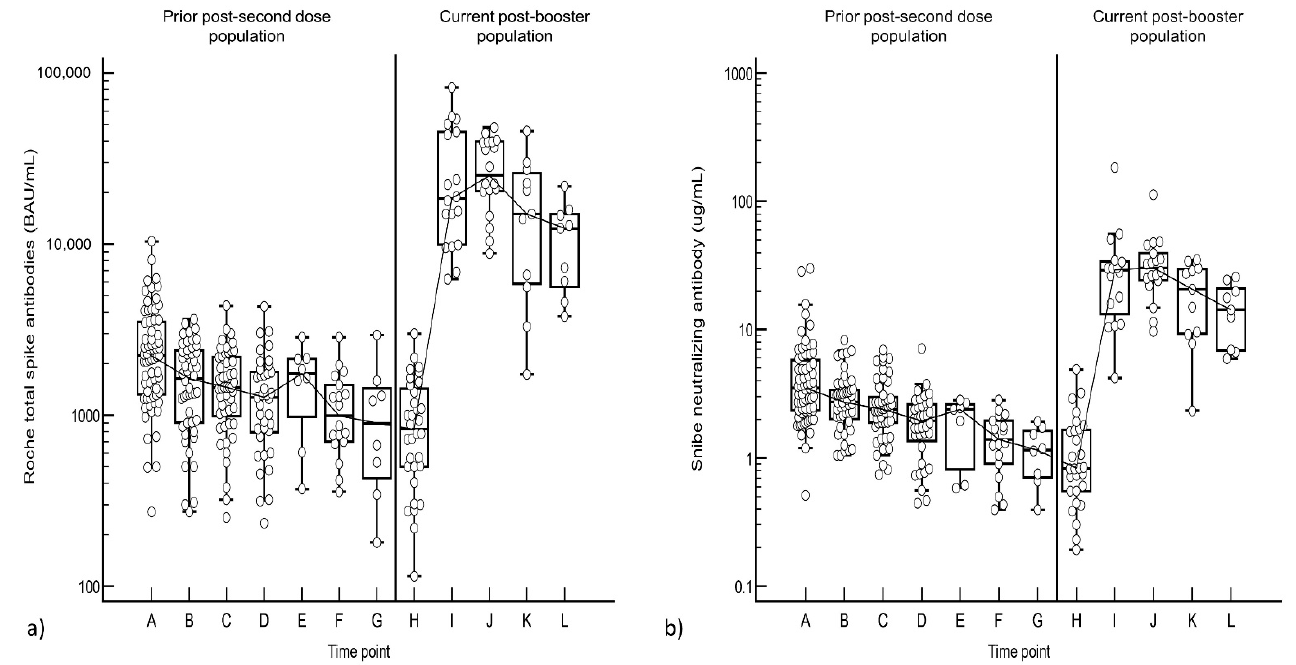
Figure 3. ( a ) Total spike and ( b ) Neutralizing Antibody trend between the second and tion doses. The time points are: A: D2D20, B: D2D40, C: D2D60, D: D2D90, E: D2D120, F: D2D150, third vaccination doses. The time points are: A: D2D20, B: D2D40, C: D2D60, D: D2D90, G: D2D180, H: Pre-D3, I: D3D20, J: D3D30, K: D3D60-75, L: D3D90. Data used in this figure E: D2D120, F: D2D150, G: D2D180, H: Pre-D3, I: D3D20, J: D3D30, K: D3D60-75, L: D3D90.